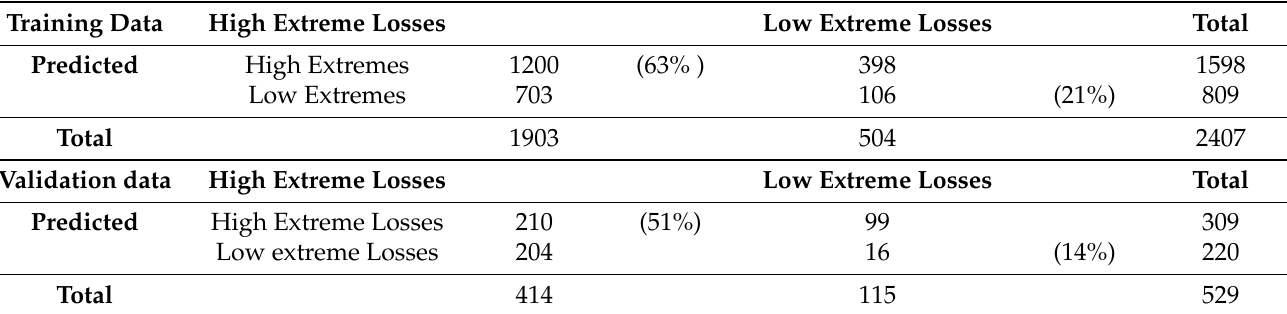
Table 6. Probabilities of correct and incorrect predicted Extreme daily.